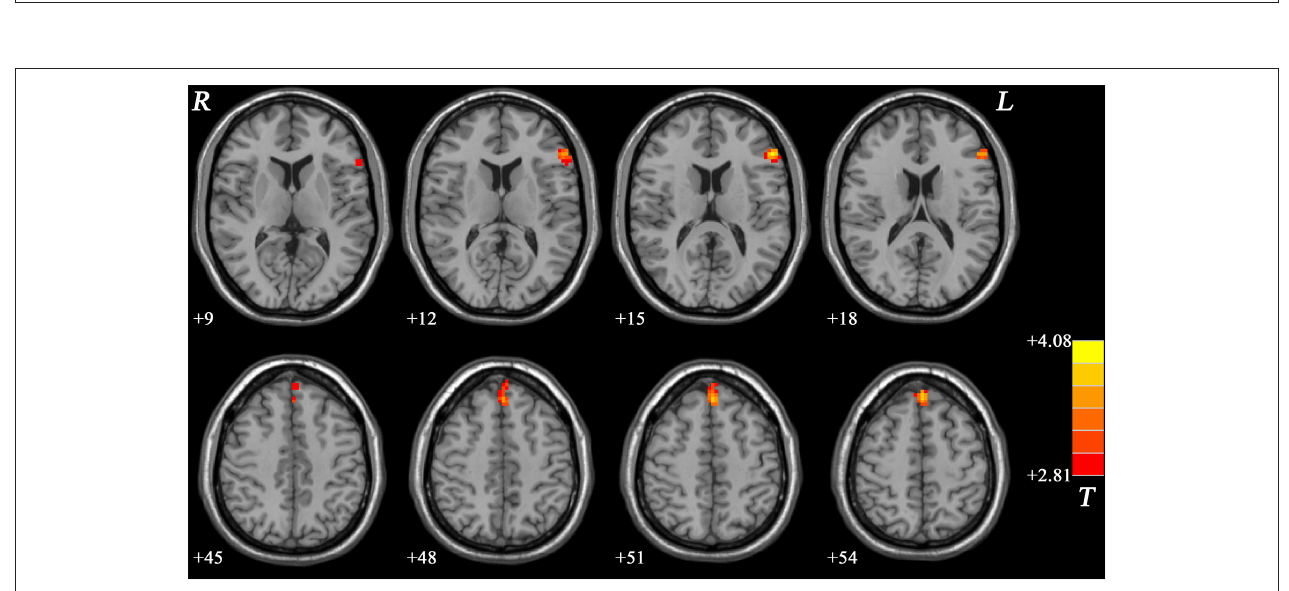
FIGURE 5 | Statistical map depicts higher ReHo in non-GI group compared with healthy controls. The threshold was FDR (false discovery rate) corrected at p < 0.05. Red denotes higher ReHo in the non-GI group. The color bar indicates T values from post-hoc t -tests. L, lest side; R, right side; GI, gastrointestinal; ReHo, regional